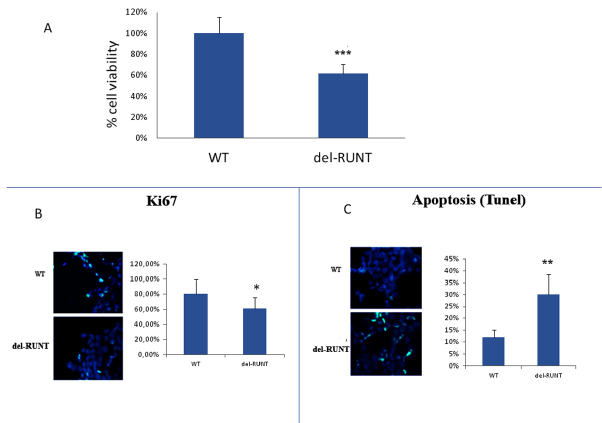
Figure 5. Significantly lower cell viability evaluated by the XTT test ( A , *** p < 0.0001) and proliferation, evaluated in immunofluorescence by ki67 positive cells ( B , magnification X40, * p < 0.05), was observed in del-RUNT compared to wild-type cells. On the contrary, apoptosis, evaluated by the TUNEL test, was significantly higher in del-RUNT cells ( C , magnification × 40, ** p < 0.01). The graphs for ki67 positive cells and apoptosis were generated by three independent experiments using 80–100 total cells per